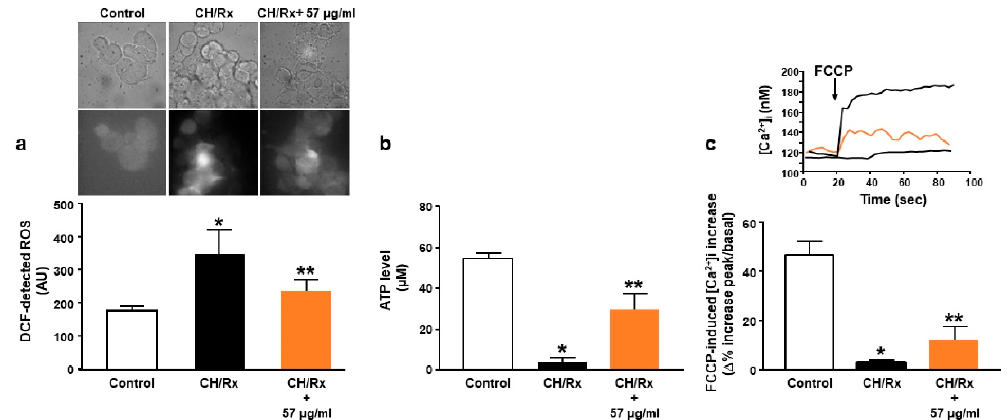
Figure 8. Effects of Ce-SANP on mitochondrial function (e.g., ROS production, ATP levels, mito- chondrial Ca 2+ homeostasis). ( a ) Arbitrary units of fluorescence in NGF-differentiated PC12 cells incubated with DCFH-DA under control conditions, after chemical hypoxia + reoxygenation alone and chemical hypoxia + reoxygenation in the presence of Ce-SANP (57 μ g/mL). Ce-SANP were added only during the reoxygenation phase. On the top of the panel, representative images for each treatment were reported. The bars show mean values ± SEM from three different experimental ses- sions. * p ≤ 0.05 vs. control; ** p ≤ 0.01 vs. CH/Rx. ( b ) basal ATP content (in μ M) in differentiated PC12 cells under control conditions, after chemical hypoxia + reoxygenation alone and chemical hypoxia + reoxygenation in the presence of Ce-SANP (57 μ g/mL). Ce-SANP were added only during the reoxygenation phase. The bars show mean values ± SEM from three different experimental ses- sions. * p ≤ 0.05 vs. control; ** p ≤ 0.01 vs. CH/Rx. ( c ) FCCP-induced [Ca 2+ ]i increase in NGF-differ- entiated PC12 cells under control conditions, after chemical hypoxia + reoxygenation alone and chemical hypoxia + reoxygenation in the presence of Ce-SANP (57 μ g/mL). Ce-SANP were added only during the reoxygenation phase. On the top of the panel, representative traces for the effects of each treatment on [Ca 2+ ] i are reported.